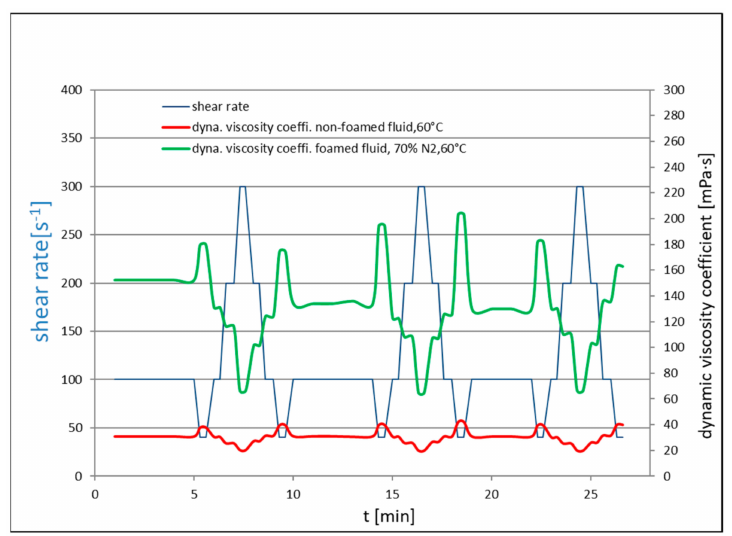
Figure 5. Viscosity of non-foamed FF2A and N 2 -foamed FF2B fluid of 70% quality at 60 ◦